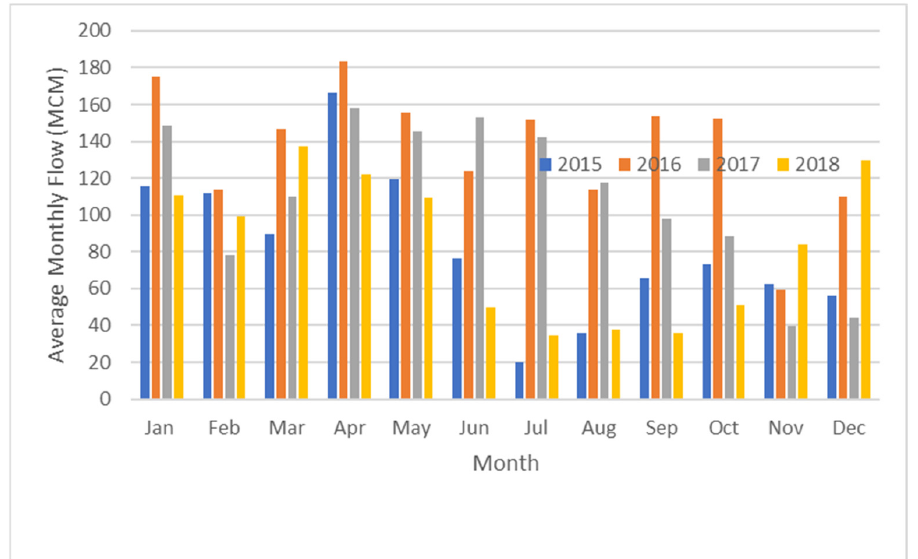
Figure 12. Average monthly flow (in MCM) to the marshland between 2015 and 2018; no trend is evident, and the flow depends on the marshland’s upstream water control.